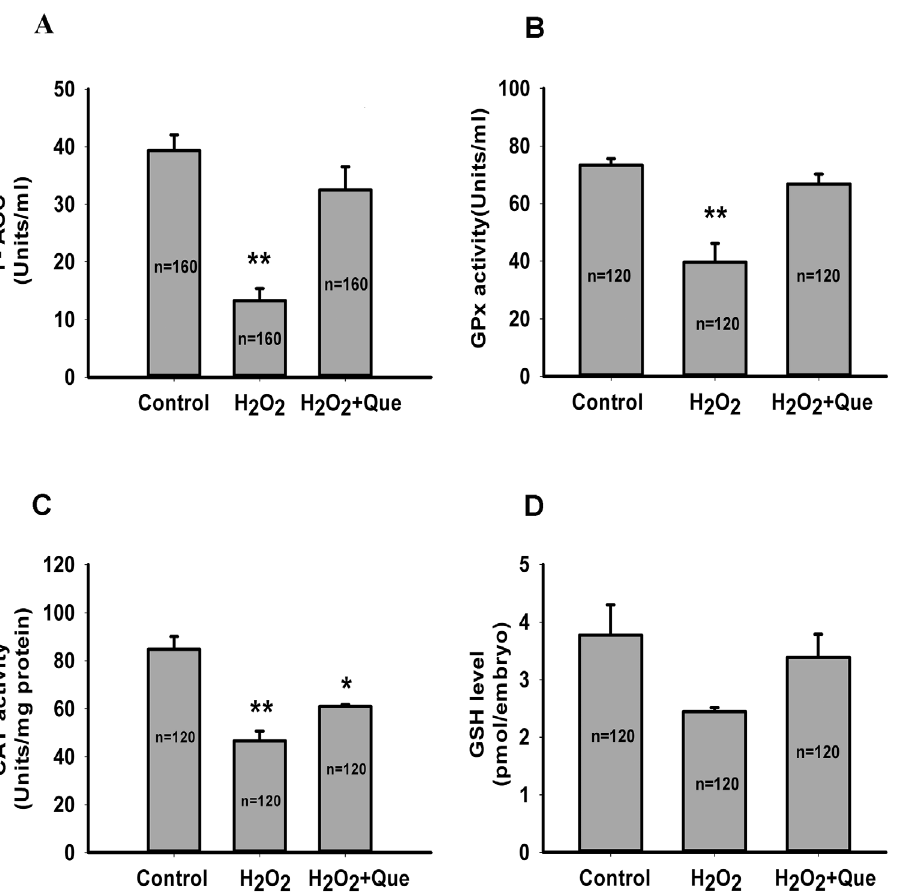
Figure 5. Quercetin attenuates H 2 O 2 -induced oxidative injury in mouse zygotes by sparing antioxidative enzymes. Zygotes were pre- treated for 3 h with 5 m M Que followed by addition of 35 m M H 2 O 2 for 15 min, and then cultured in the presence of Que until day 5.5. (A) T-AOC, (B) GPx activity, (C) CAT activity and (D) GSH level were then measured. Data are presented as the mean 6 SEM from at least three independent experiments and the number ‘‘n’’ in middle of each bar of the graphs indicates the total number of treated zygotes. ** P , 0.01, * P , 0.05 compared with the control group (One-way ANOVA).